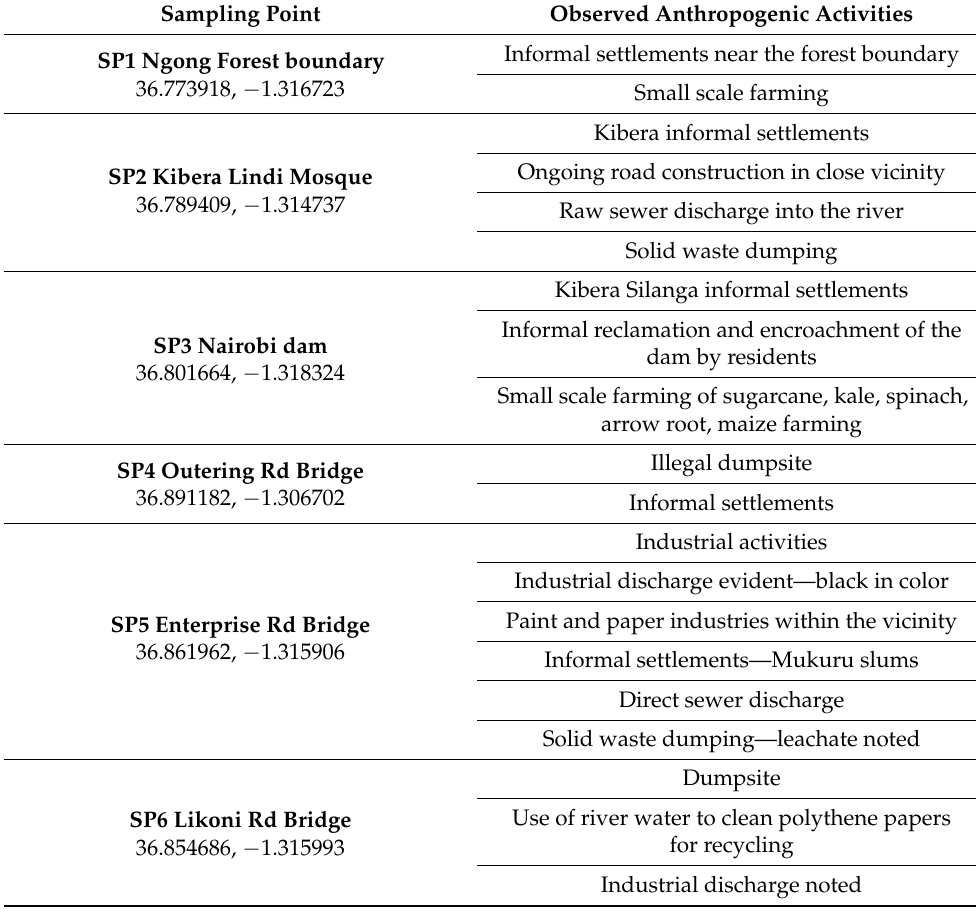
Table 1. The anthropogenic activities affecting the water quality of Ngong River. Sampling